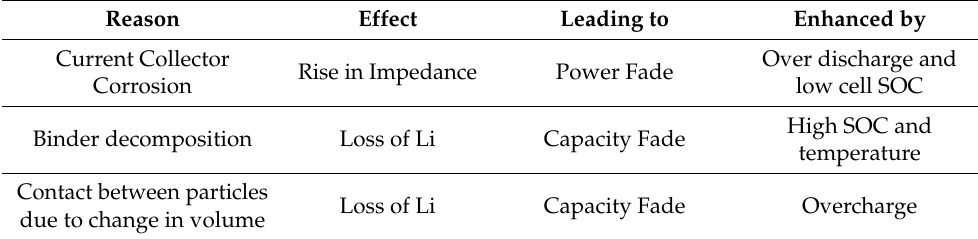
Table 4. Aging due to composite electrode materials.